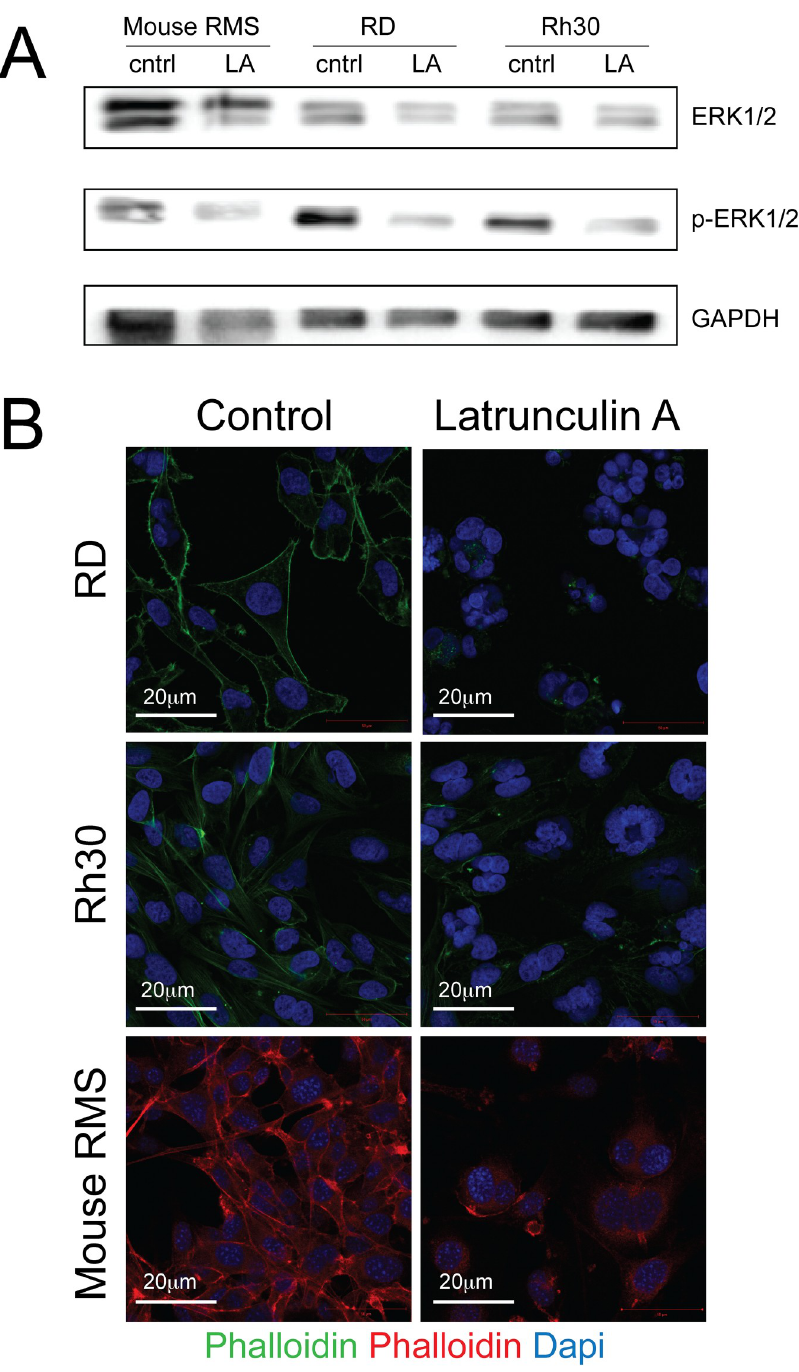
Fig 4. Protein expression levels of ERK and pERK in human and mouse rhabdomyosarcoma cell lines after treatment with Latrunculin A. Human RD sarcoma cells were exposed to 250nM latrunculin A, human Rh30 RMS cells to 100nM latrunculin A and mouse RMS sarcoma cells to 100nM latrunculin A. Different concentrations were chosen due to differences in latrunculin A sensitivity between sarcoma cell lines. (A) Evaluation of ERK1/2 (42/ 44kDa), p-ERK1/2 (22/ 44 kDa) and GAPDH (37 kDa) by Western blotting demonstrated reduced ERK1/2 phosphorylation in latrunculin A-treated sarcoma cells. (B) The F-actin cytoskeleton was evaluated using phalloidin staining. Actin organization was profoundly disrupted in latrunculin A-treated (top right panel)) vs. control (top left panel) RD cells, latrunculin A-treated (middle right panel) vs. control (middle left panel) Rh30 cells and latrunculin A- treated (bottom right panel) vs. control (bottom left panel) mouse RMS cells. Please also see S1 Raw images.